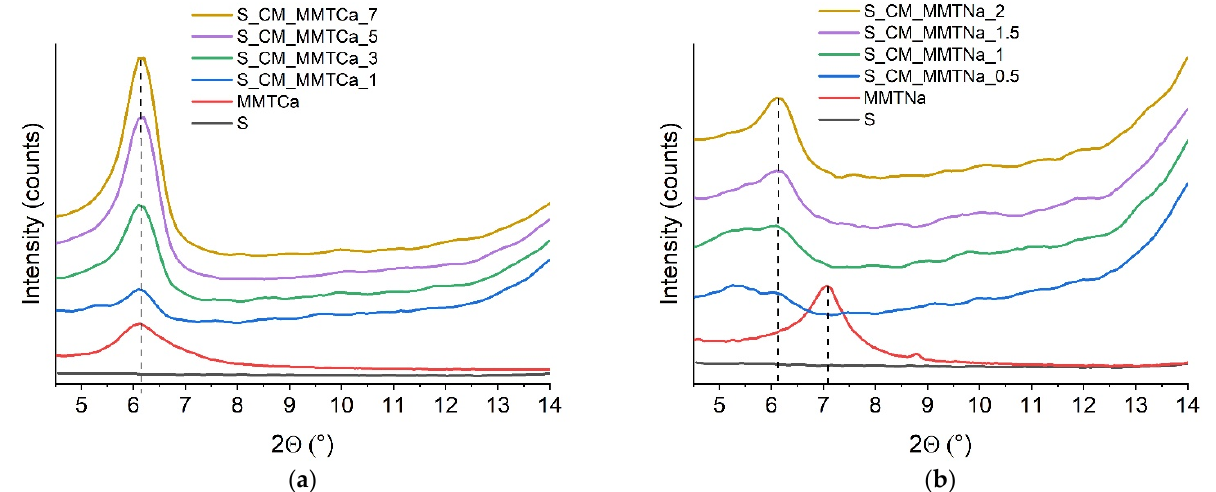
Figure 5. XRD diffractograms of neat montmorillonite and starch films with various ( a ) MMTCa, and ( b ) MMTNa contents.